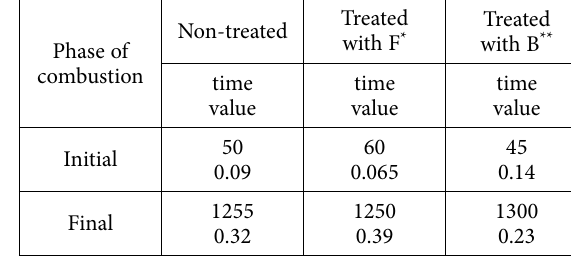
Table 5. Maximum values of CO concentration in kg/kg and corresponding times in sec obtained during the initial and combustion final stages of non-treated and treated pine timber (without piloted ignition) Treated Treated Non-treated with F * with B ** Phase of combustion time value